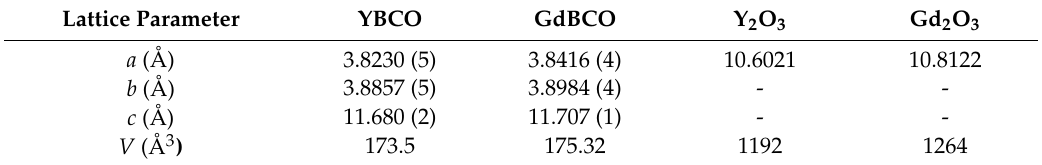
Table 1. Lattice parameters in orthorhombic REBCO 1 and cubic C-type RE 2 O 3 2 phase. RE = Y, Gd. Lattice